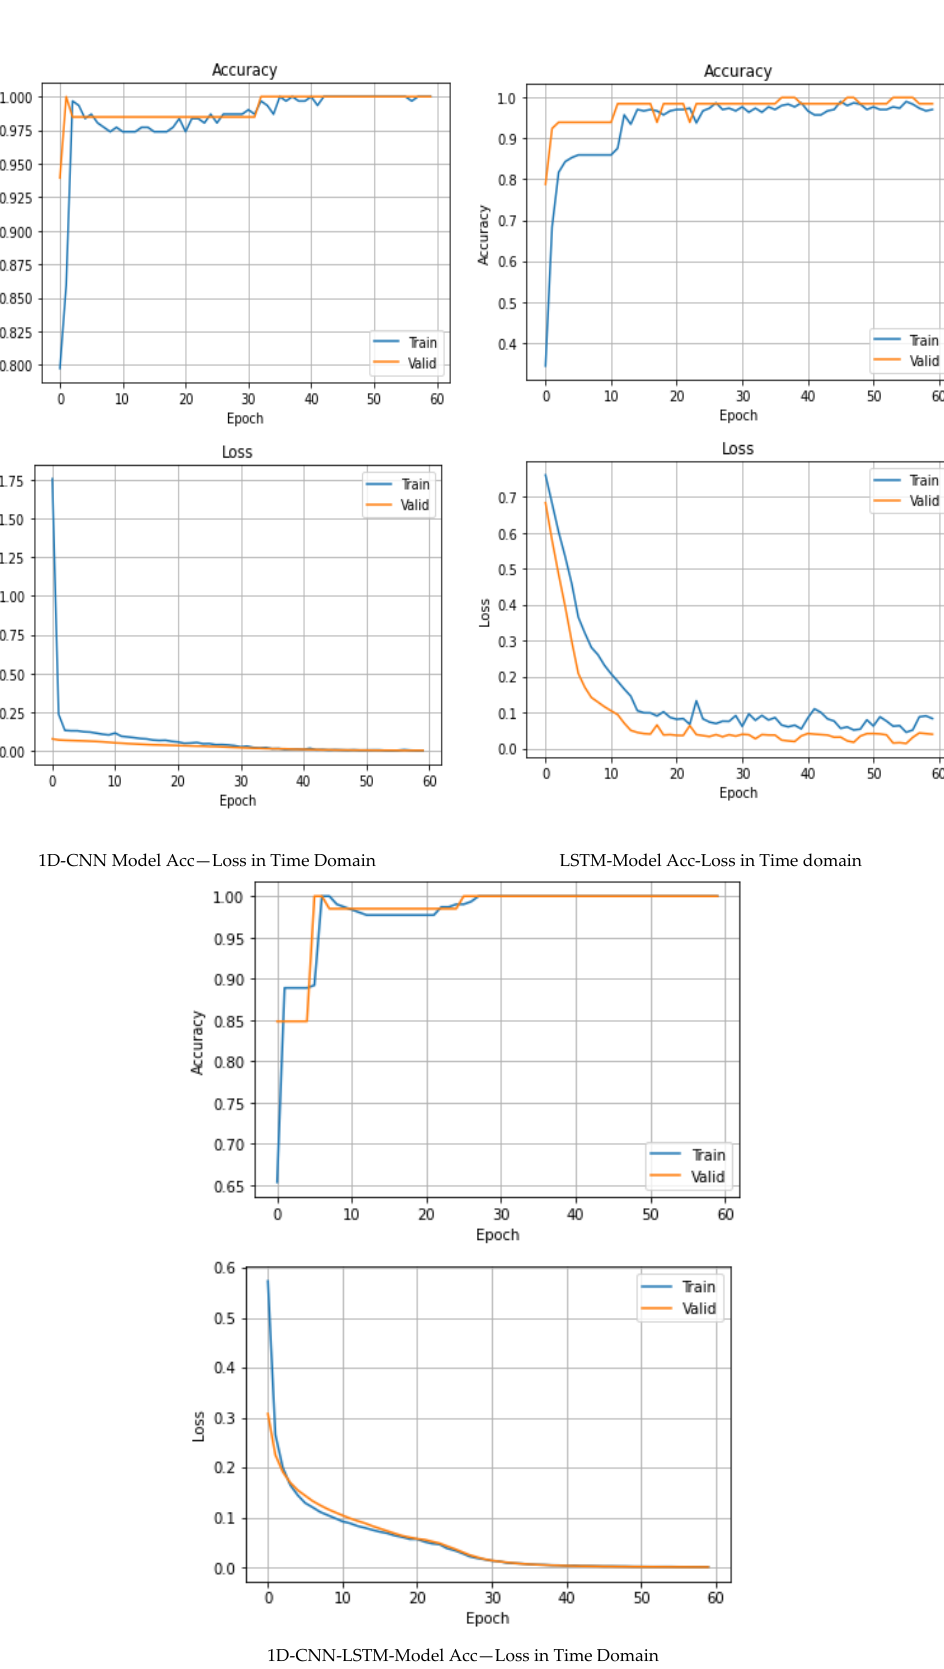
Figure 6. The accuracy and loss curves are shown in the time domain for the 1D-CNN, LSTM, and 1D-CNN-LSTM models.